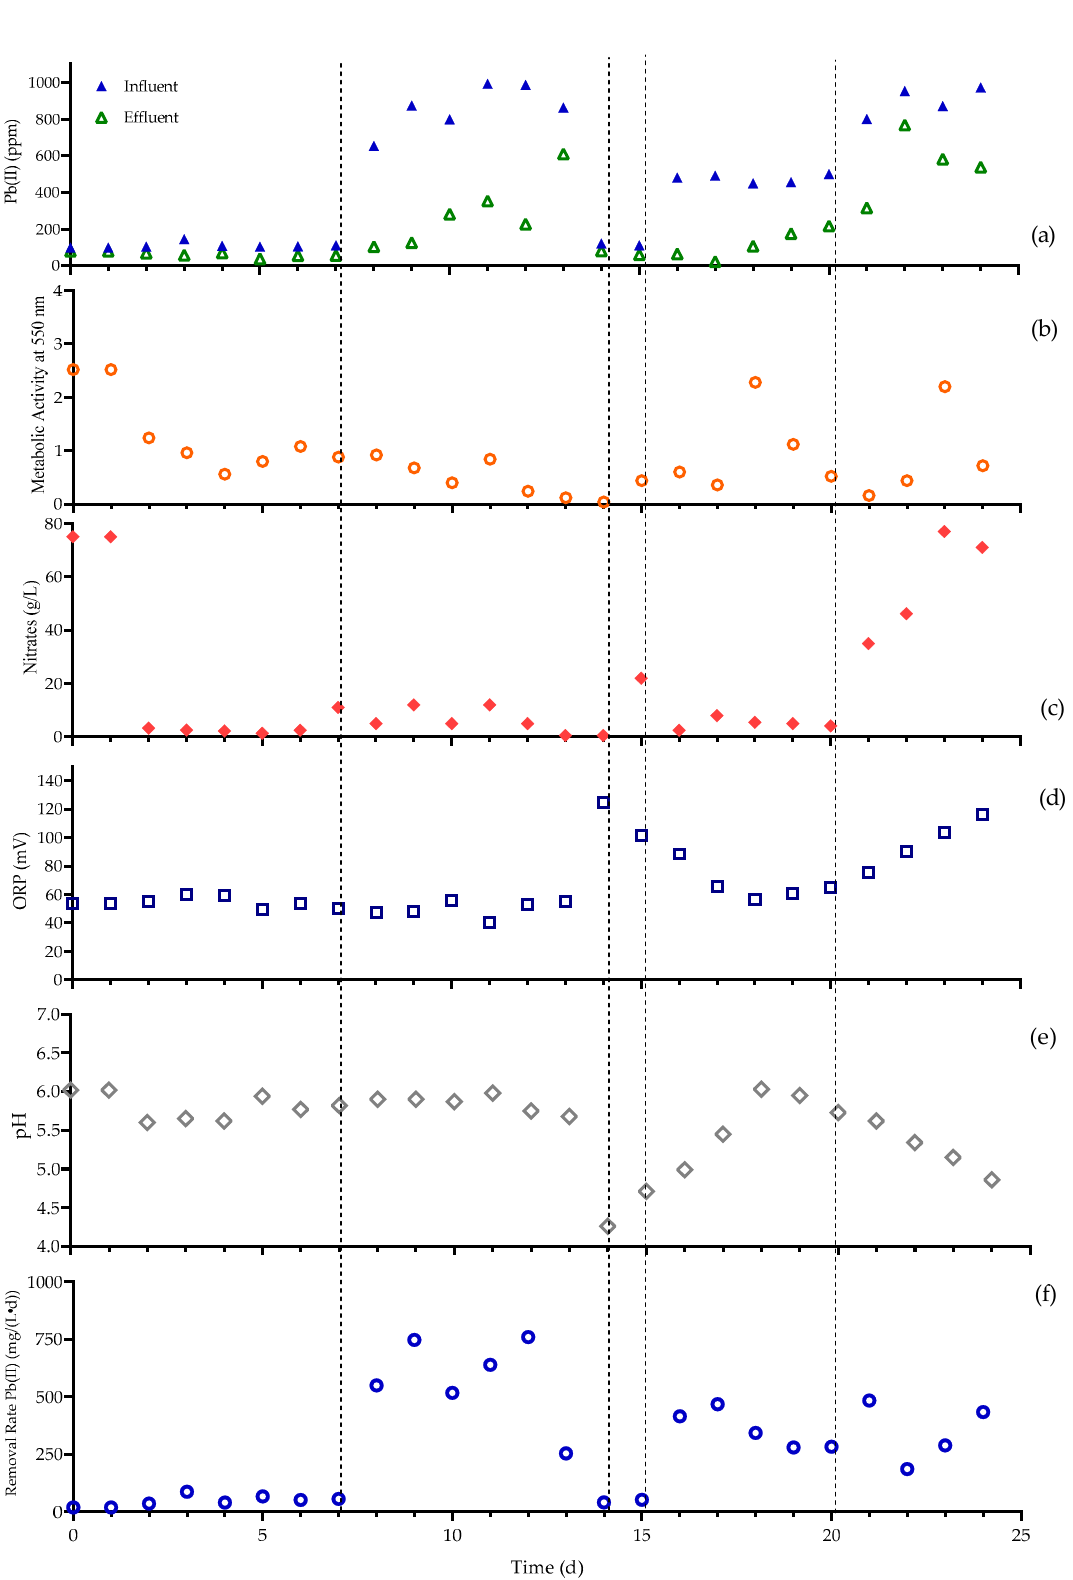
Figure 4. The lead level ( a ), metabolic activity ( b ), nitrate measurements ( c ), ORP ( d ), pH ( e ) and Pb(II) removal rate ( f ) over time for run 3a.